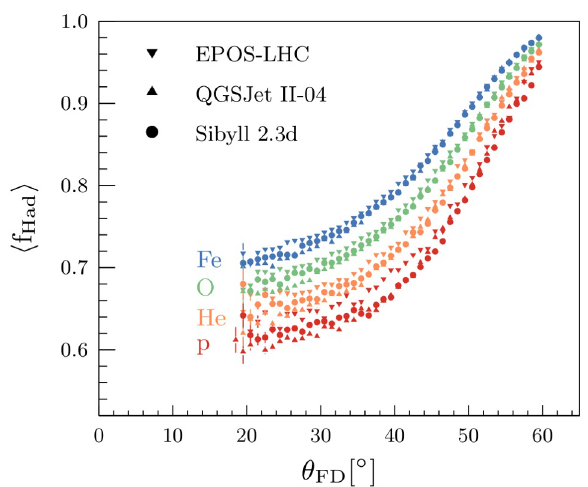
Figure 1: Average fraction of the hadronic signal at 1000 m, f Had = S Had / S (1000), as a function of the zenith angle reconstructed by the FD. Signals from four primaries (colors) of energies 10 18 . 5 − 10 19 . 0 eV and three models of hadronic interactions (markers) are